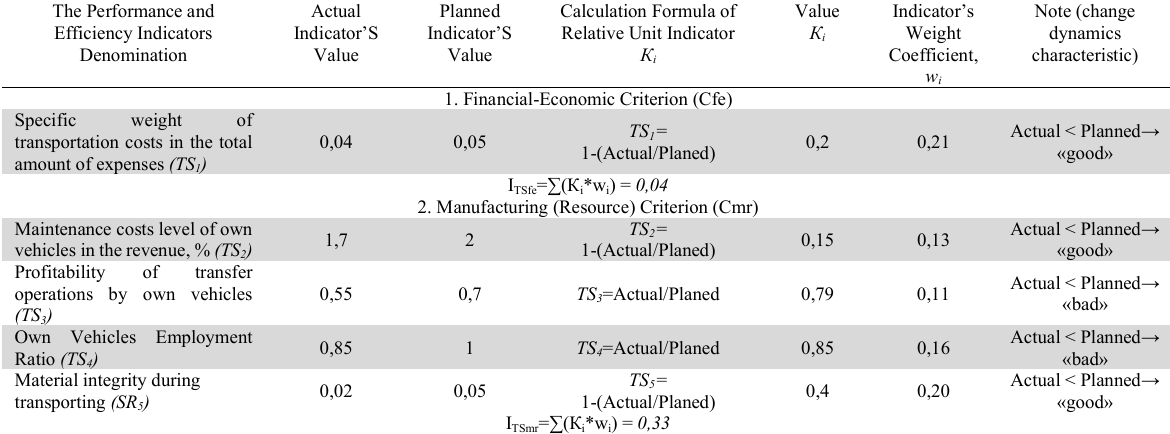
Determination of performance and efficiency indicators of transport supply business processes execution of a building production